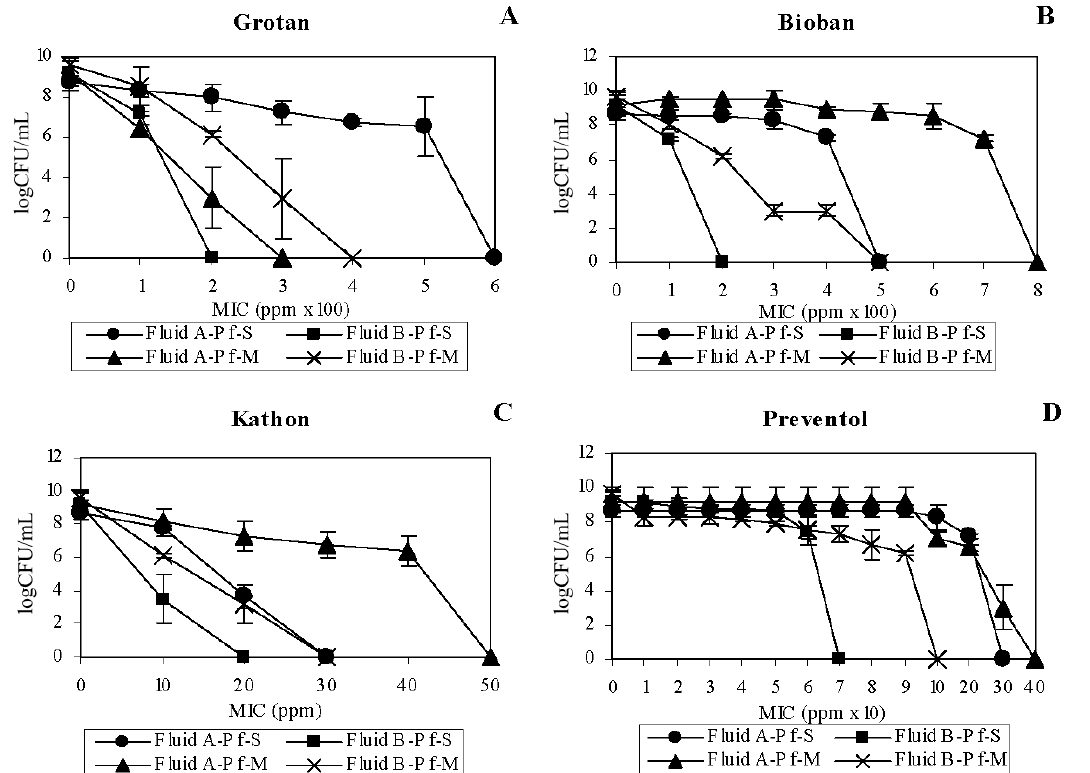
Figure 2. Effect of fluid type on biocidal efficacy toward P. fluorescens . Two different semi-synthetic fluid types (Fluid A and Fluid B) were used to investigate the biocidal activity of four individual test biocides namely, Grotan (Panel A ), Bioban (Panel B ), Kathon (Panel C ) and Preventol (Panel D ) in terms of minimum inhibitory concentration (MIC), either in single culture (pure) suspension or in mixed culture suspension (1:1 ratio with M. immunogenum ) of P . fluorescens . The MIC values were based on 100% killing of the test organism and are means of the triplicates. The test organism was exposed to varying levels of the individual biocides for 15 min each in the two test fluid matrices. Abbreviations: Pf, P. fluorescens ; S, Single culture suspension (pure suspension); M, Mixed culture